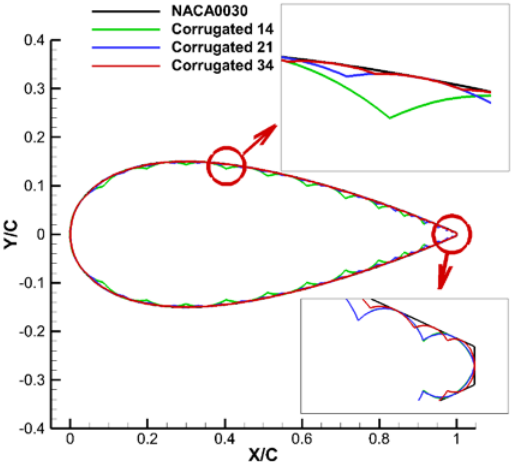
Figure 2. Comparison of the corrugated airfoil.